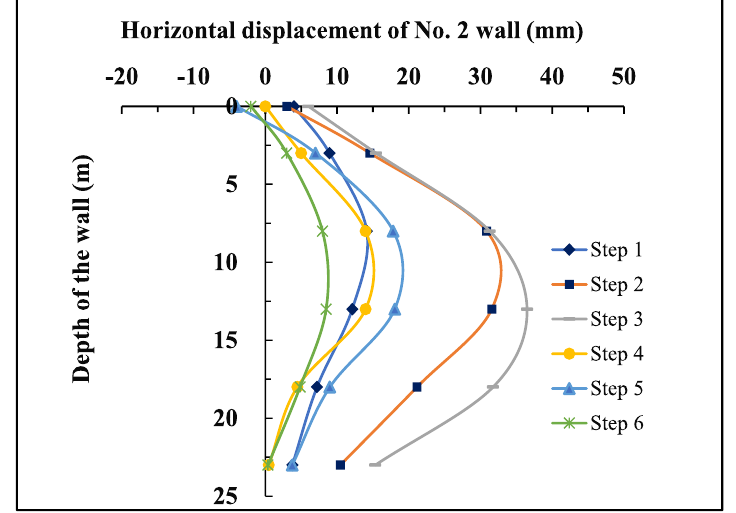
Figure 8. Horizontal displacement of wall No. 2.